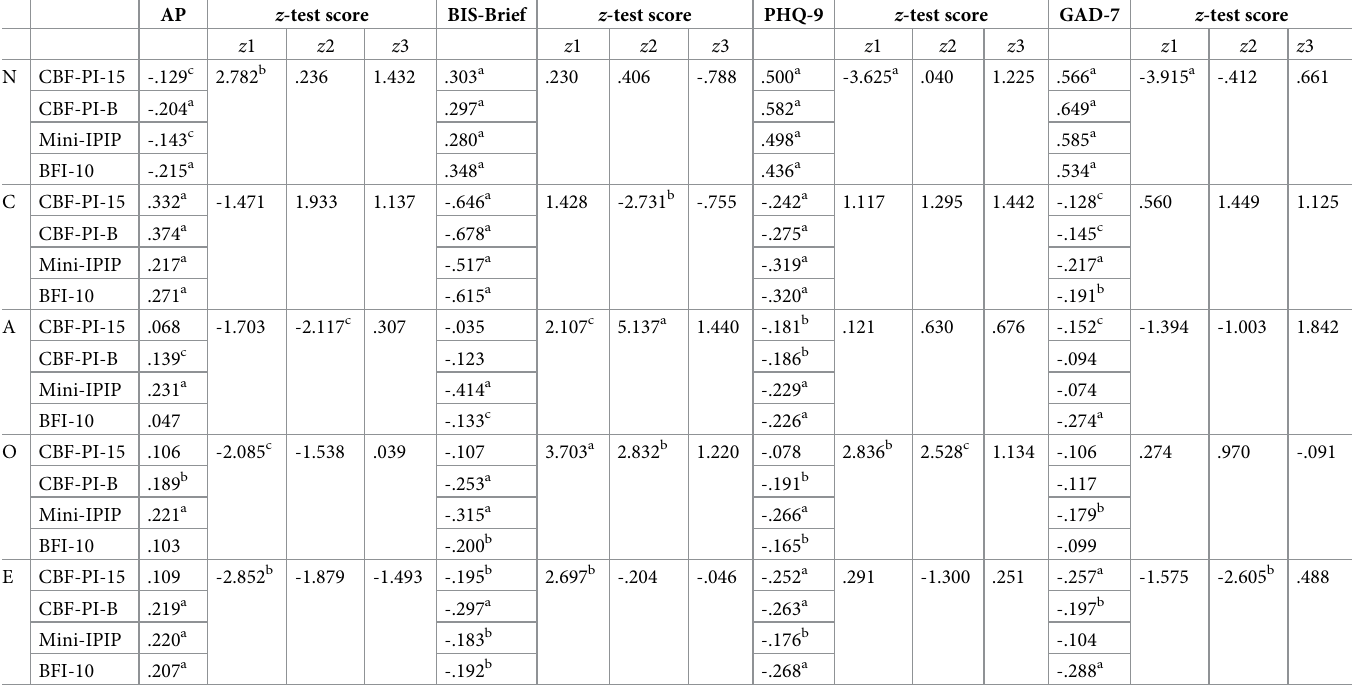
Table 5. Correlations between personality measures and criterion-related